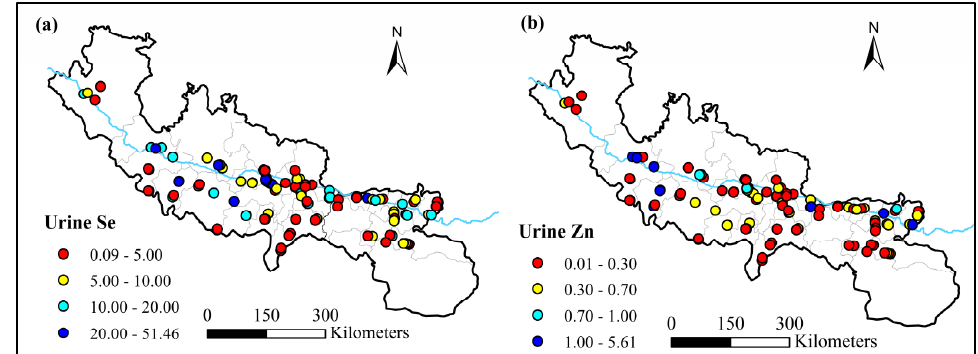
Figure 8. Distribution of Se (µg·L −1 ) and Zn (mg·L −1 ) concentration in urine samples. ( a ) Urinary Se